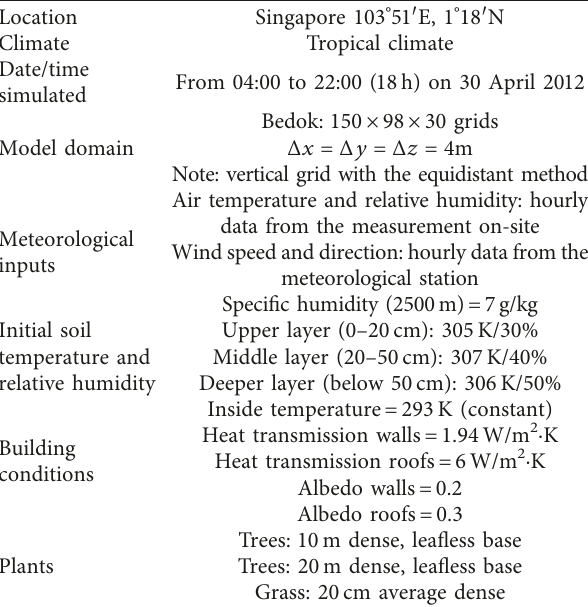
Figure 3: Model domain for the study area. Table 2: Boundary conditions and initial setting of the ENVI-met